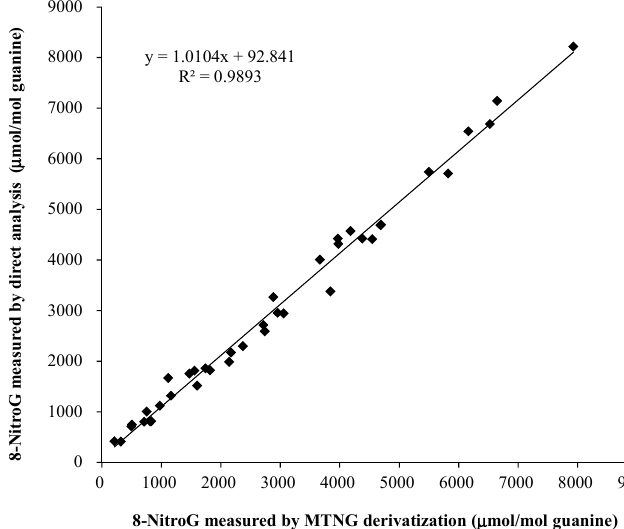
Figure 3. Correlation between quantitative results obtained through online SPE LC-MS/MS analyses with (this work) and without glyoxal derivatization [22]. The DNA samples containing various levels of 8-nitroG were prepared by treating calf thymus DNA with peroxynitrite at concentrations of 2.5–300 μ M.